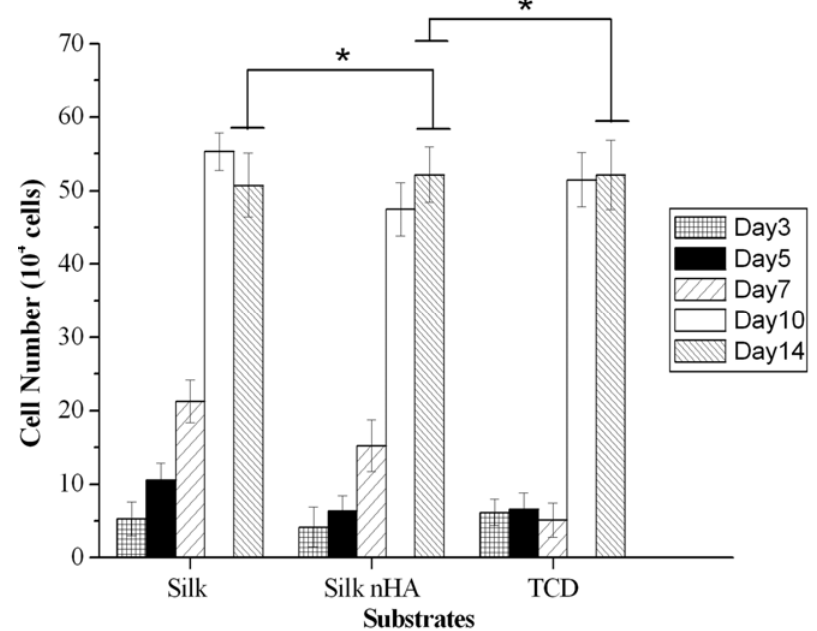
Figure 14. Cell proliferation on pure and mineralized silk nanofibers after 3 to 14 days of cell culture. Significant difference between different materials groups were denoted as * ( p ≥